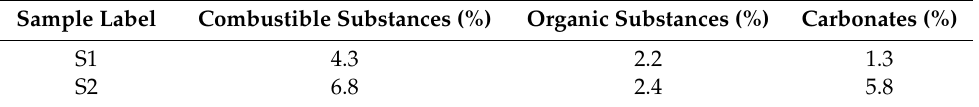
Figure 1. Comparative analyses of two raw materials X-ray structural analysis (XRD) diagrams. Table 3. Results of combustible, organic substances and carbonate content in the raw materials.